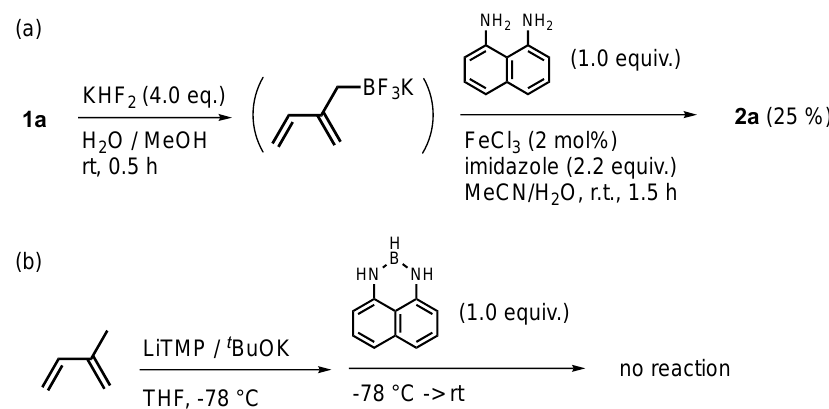
Scheme 3. Unsuccessful attempts for the preparation of 2a : (a) a synthetic route via trifluoroborate salt, (b) direct functionalization of potassium isoprenide.